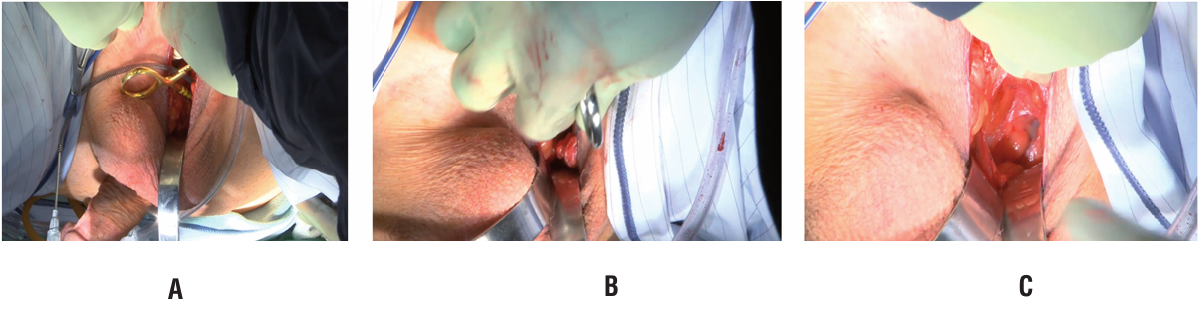
Figure 2 - A) Retractor placed into external inguinal ring through perineal incision B) Placement of ring clamp into external inguinal ring C) Filling of positioned